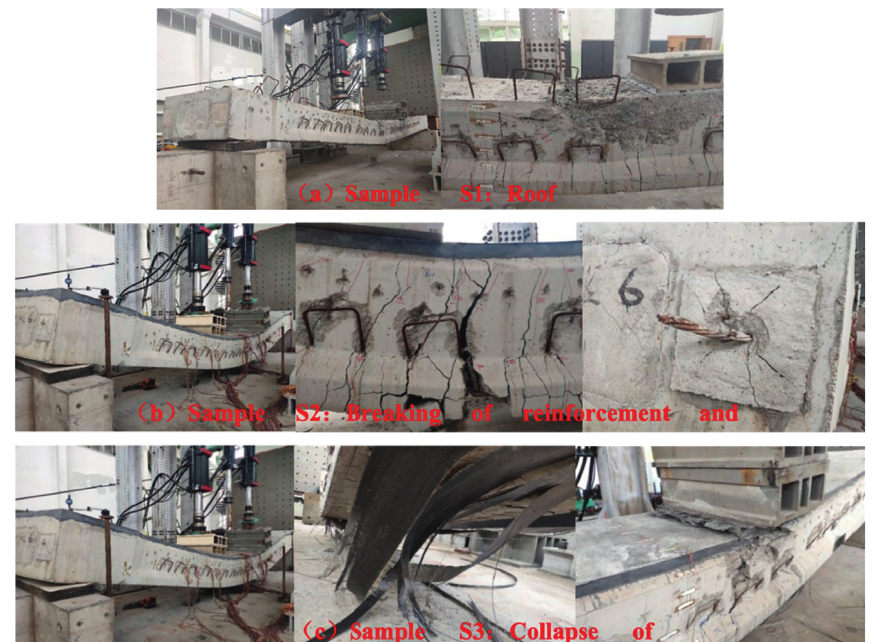
Figure 9: Failure of specimens S1, S2, and S3. (a) Sample S1: roof. (b) Sample S2: breaking of reinforcement. (c) Sample S3: collapse of UHPC.